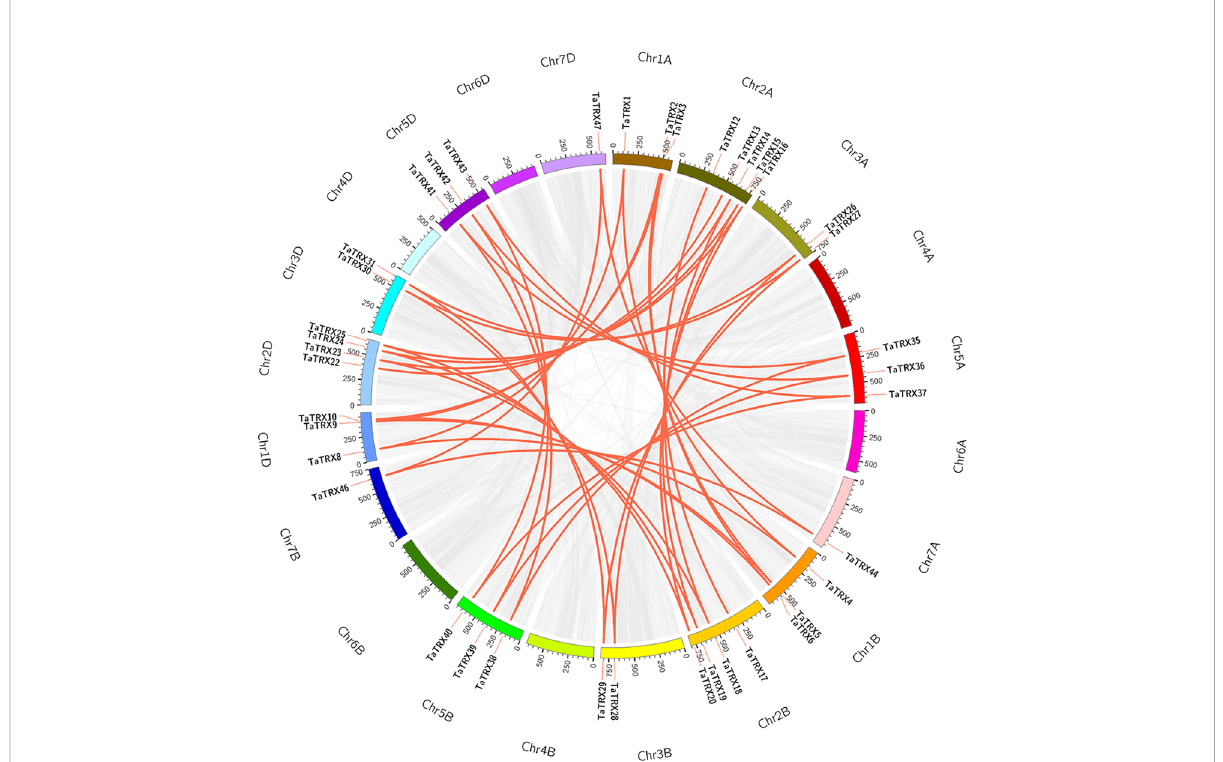
FIGURE 3 Distribution and duplication events of typical TaTRX genes across wheat genome. All typical TaTRX genes were mapped to 21 wheat chromosomes in a circle using Circos tool, and segmental duplications were mapped to their respective locations. Gray regions indicated all synteny blocks within the wheat genome, while red lines represented segmental duplications. The chromosome numbers were marked outside of the